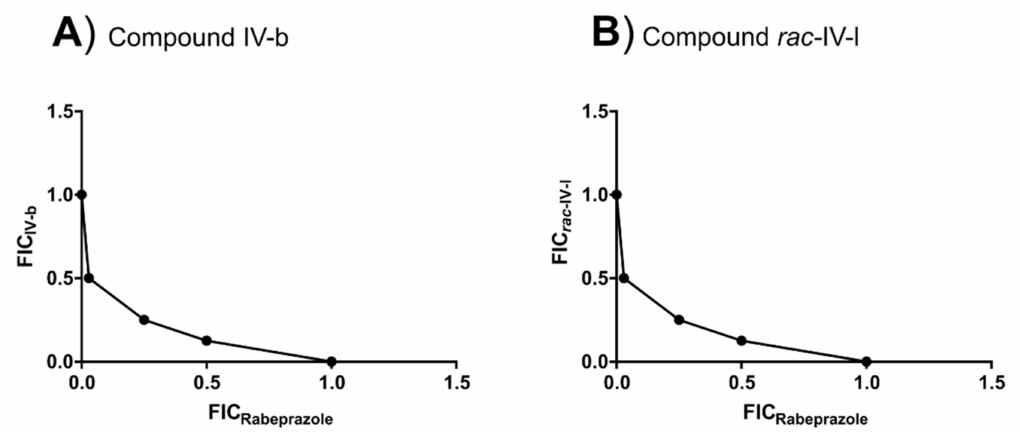
Figure 6. Synergism between rabeprazole and compounds IV-b ( A ) and rac -IV-l ( B ) against H. pylori strain ATCC 700392. The concave curve obtained in both graphs by representing FIC values indicates a synergistic relation between rabeprazole and those IV -related compounds. The closest point to the axes intersection relates to the most effective combination of compounds to inhibit H. pylori growth, which is recorded as